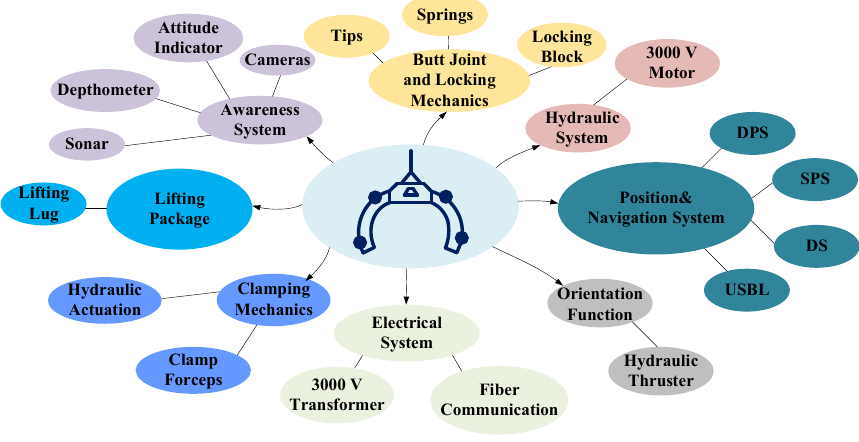
Figure 11. The manipulator assembly.